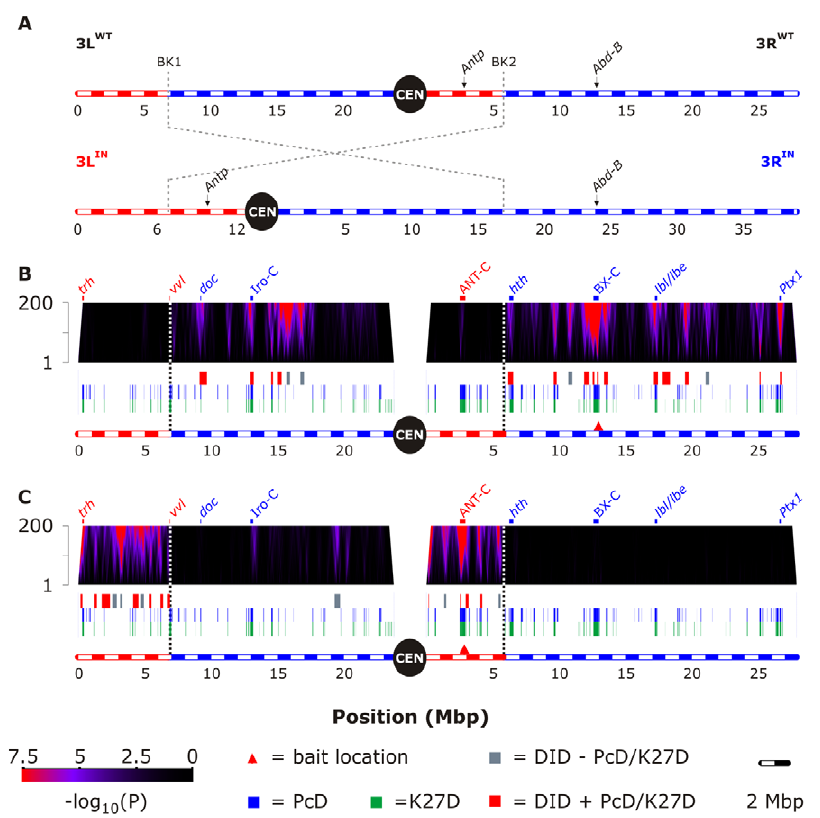
Figure 7. Interactions are constrained by chromosome architecture. (A) A schematic overview of the wild type and inverted chromosome 3. The wild type strain used in this study ( w 1118 ) is shown on top. Dashed lines indicate the annotated positions of the break points (BK1 and BK2) present in the inverted chromosome of In(3LR)sep (bottom). Sequences on the inverted left arm 3L IN are red and 3R IN blue. Positions of the baits are indicated. (B–C) Domainograms show interactions of Abd-B (B) and Antp (C) on the inverted third chromosome. Note that all domainograms are plotted in the wild type orientation, which allows direct comparison with wild type data (Figure 2B, 2C). The colors on the x-axes indicate location on inverted chromosome (red = 3L IN ; blue = 3R IN ). Exact positions of the break points are highlighted by dashed vertical lines. Rest of plot details are described in Figure 1B and Figure 2.